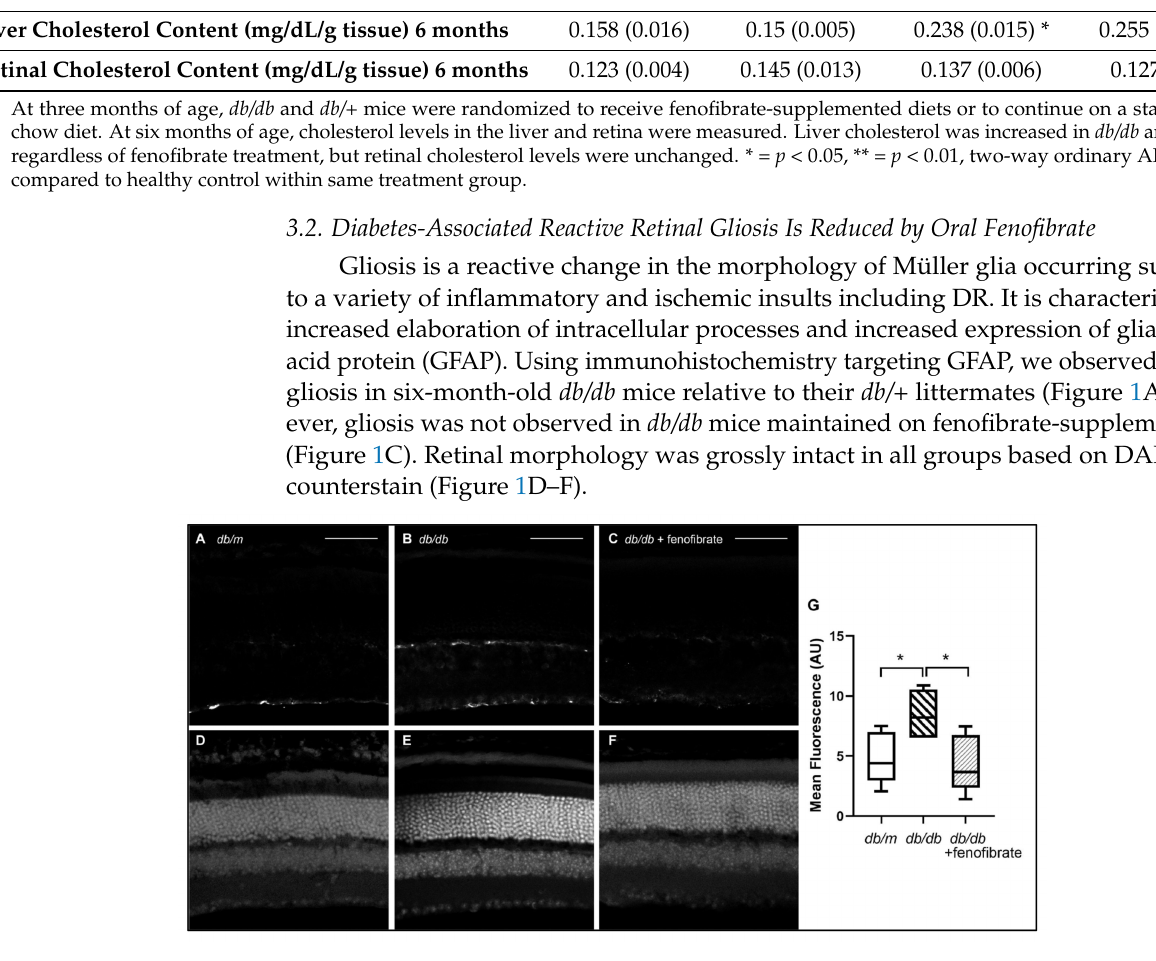
Figure 1. Fenofibrate reduces diabetes-associated reactive retinal gliosis. Retinas were harvested from db/db mice and their heterozygous siblings at six months of age, fixed, sectioned and labeled with glial fibrillary acidic protein (GFAP) or 4 (cid:48) ,6-diamidino-2-phenylindole (DAPI). ( A ) Heterozygous db/+ mice show minimal GFAP staining localized to the internal limiting membrane. ( B ) Diabetic db/db mice showed evidence of gliosis, with GFAP expression localized to the inner nuclear layer (INL) as well. ( C ) Oral fenofibrate treatment of db/db mice abrogated gliosis, with GFAP staining appearing comparable to that of db/+ siblings. ( D – F ) DAPI was used as a counterstain to demonstrate nuclear morphology. Scale bars represent 50 microns. ( G ) Quantification of relative fluorescence signal between experimental groups ( n = 6/group). * = p < 0.05, one-way